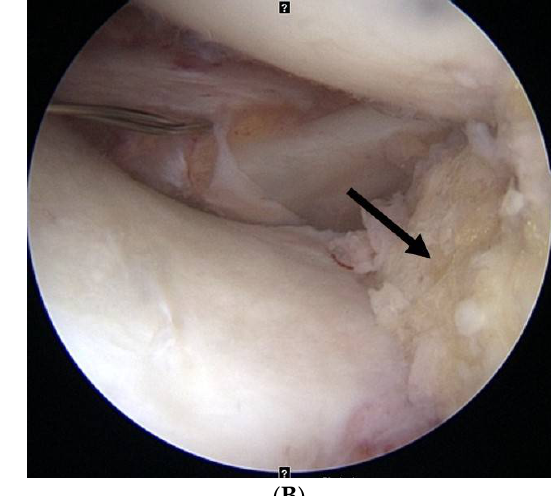
Figure 3. Capsulodesis using an all-soft suture anchor. ( A , B ) Two pairs of strands of suture anchor are pulled out of the lateral capsule. ( C , D ) They form an X shape and are tied. The lateral capsule is attached to the lateral tibial plateau after capsulodesis.